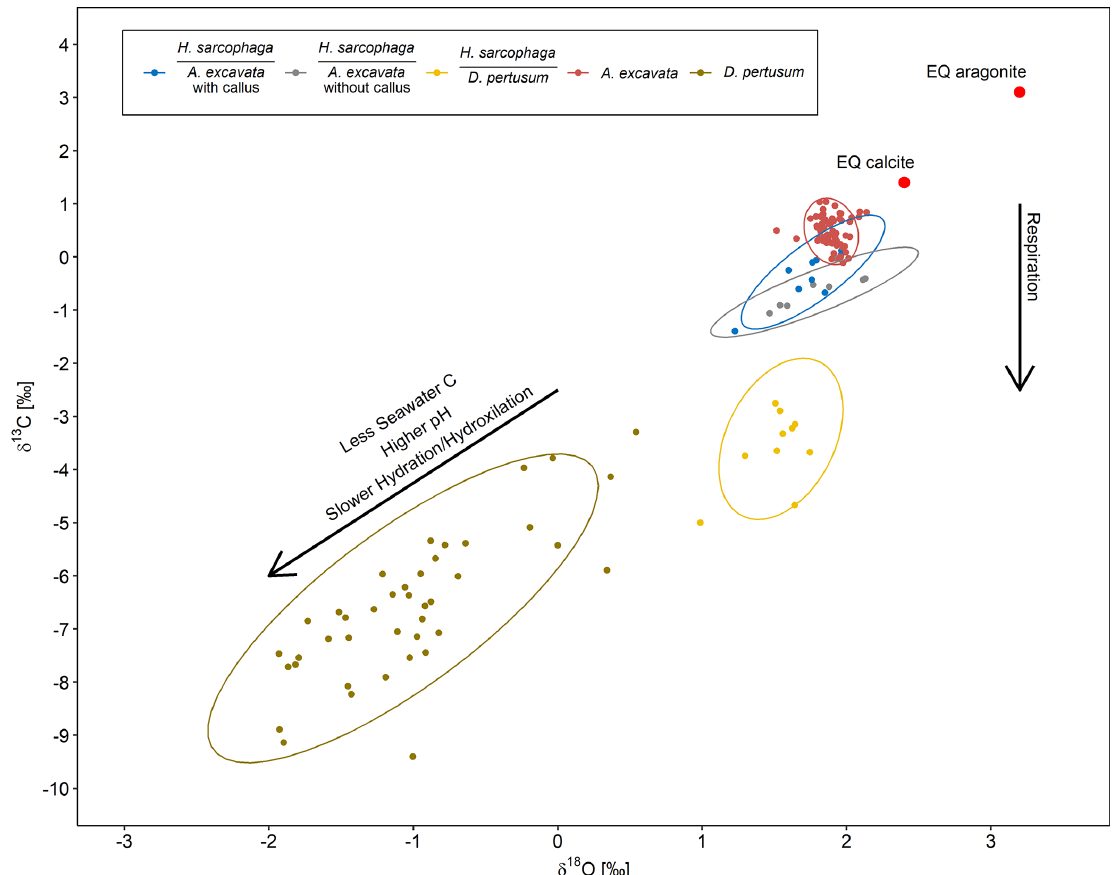
Figure 8. δ 18 O plotted against δ 13 C for H. sarcophaga from different host organisms and the host organisms A. excavata and D. pertusum with a 95% confidence ellipse. Arrows show compositional changes induced by kinetic effects and respiration. Text below the horizontal lines in the legend is the host organism that H. sarcophaga grew on. Red points show the equilibrium composition for calcite and aragonite as calculated from the isotopic composition of the ambient